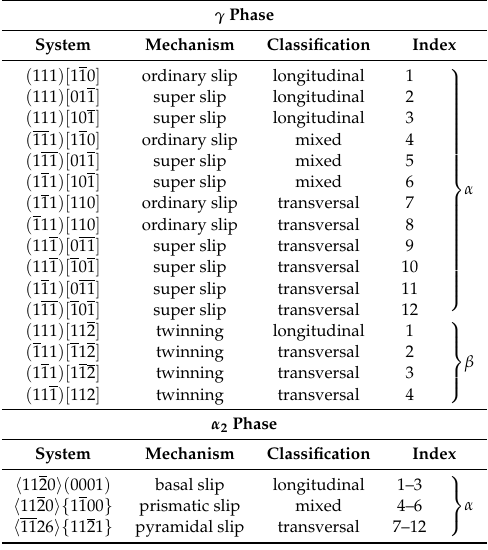
Table 1. Slip and twinning systems in γ and α 2 phase with morphological classification according to [6]. γ Phase System